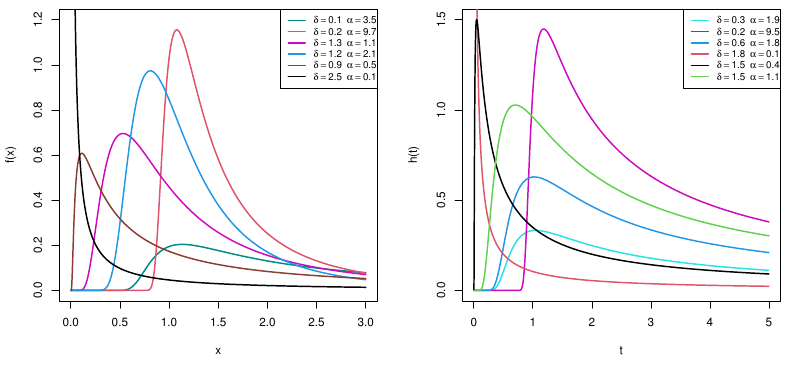
Figure 1. Shapes of density and hazard functions of the